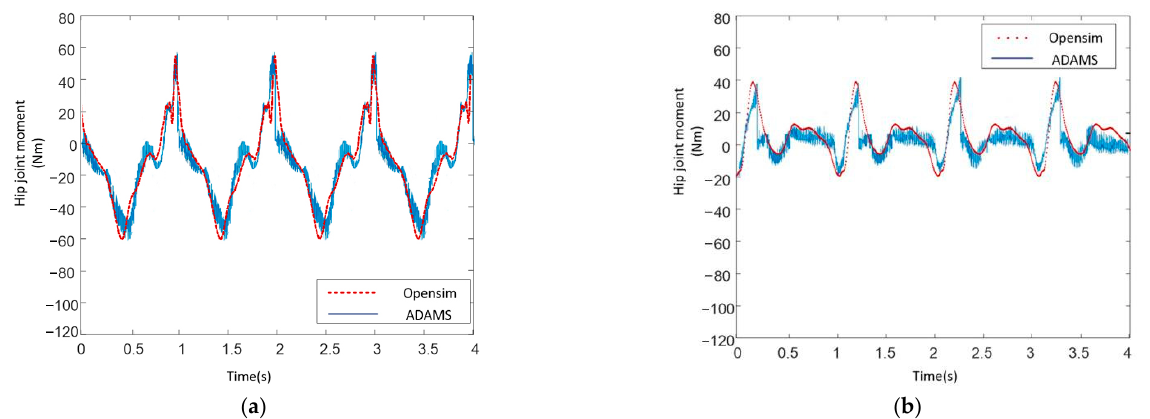
Figure 21. Simulation curves of human body. ( a ) hip joint moment curve; ( b ) knee joint moment curve.